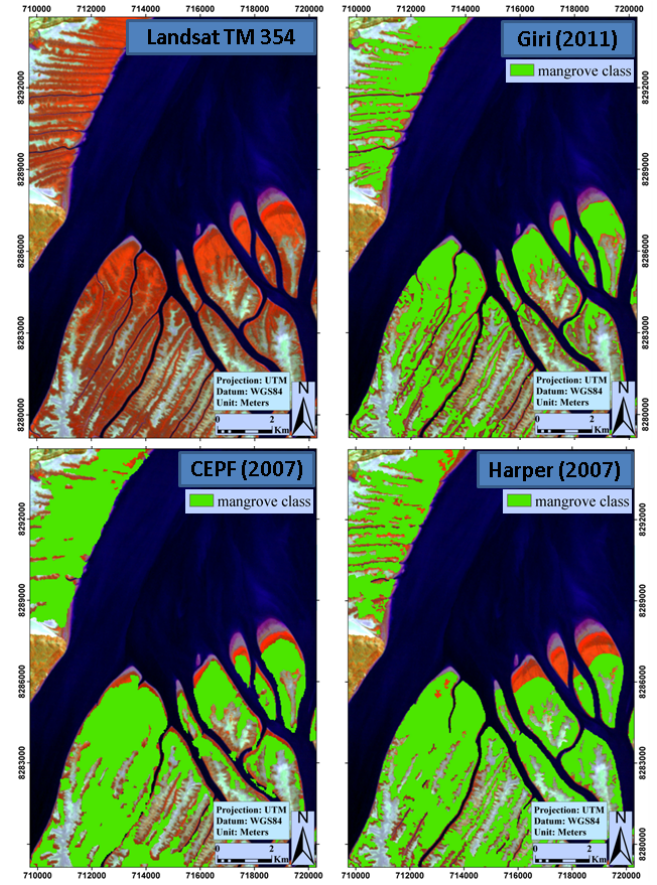
Figure 3. A Landsat TM Blue-Green-Red 354 false color composite from July, 2011 is shown in the top left panel wherein mangroves appear primarily in shades of red. Mangrove coverage from three national data-sets ( i.e. , Giri [69]; CEPF [71]; Harper et al. [72]) is overlain on the Landsat composite in the three other panels. This comparison illustrates how data produced by Giri [69] provide the most comprehensive (in terms of representing actual known mangrove area) and contemporary (in terms of year) mangrove coverage; as is illustrated by the variably represented mangrove covered islands in the middle-right of each panel. The area shown in all four panes is a portion of MHJ.